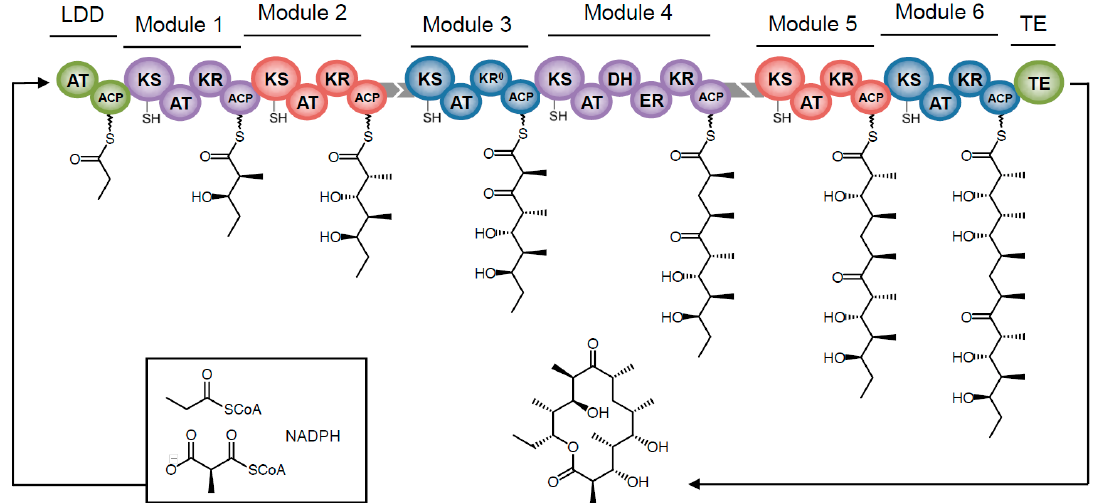
Figure 2. An example of mPKS architecture. This is a simplified diagram of the domain organization in of the 6-deoxyerythronolide B synthase (DEBS). Each module is colored differently, with domains indicated by labels, and docking domains colored in grey. Propionyl-CoA acts as a starter unit, and methylmalonyl-CoA is the elongation unit, added each time after chain is transferred from one module to the next. The thioesterase (TE) domain cleaves the acyl chain from the mPKS, sometimes causing macrocyclization. The KR ° domain of DEBS M3 has lost its reductive activity, resulting in an unreduced ketone in the final product.